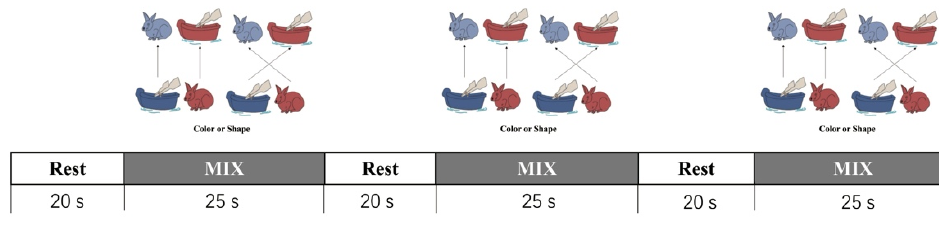
Figure 2. The DCCS task paradigm.